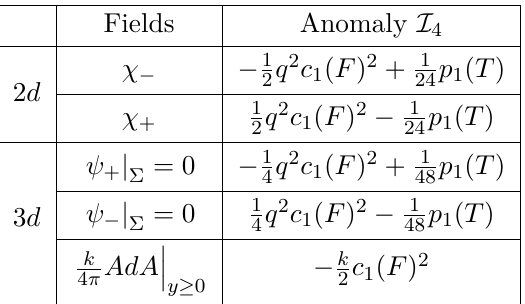
Table 1 . The ’t Hooft anomalies for 2d Weyl fermions χ ± , 3d Dirac fermions ψ ± with different boundary conditions, and a classical 3d CS action on R 2 , 1 the vector U(1) symmetry for which A is the background gauge